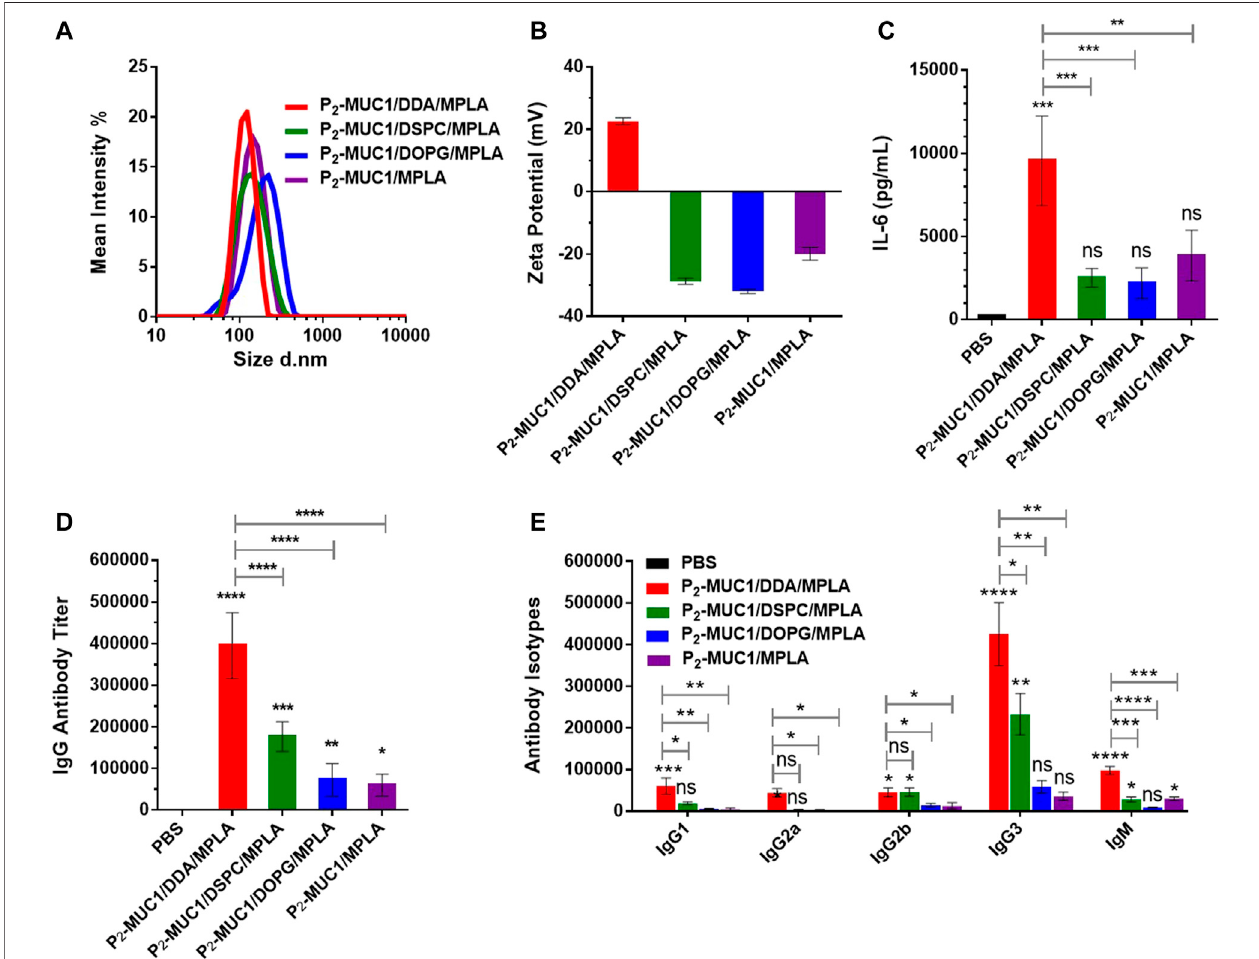
FIGURE3| DLS (A) and zetapotential (B) results forvaccines.Values arepresented asthemean±SD( n =3).Thesecretionsofcytokines (C) ,MUC1-speci fi cIgG antibody (D) andantibodyisotypes (E) weredetectedbyenzyme-linkedimmunosorbentassay(ELISA)( n =5).Control:phosphate-bufferedsaline(PBS).****, p < .0001, ***, p < .001, **, p < .01, and *, p < .05 compared with the control group by one-way analysis of variance (ANOVA) with the Tukey ’ s HSD test. Comparisons between different groups were also conducted by ANOVA using Tukey ’ s HSD test. Data represent the mean ± SD of fi ve mice from three separate